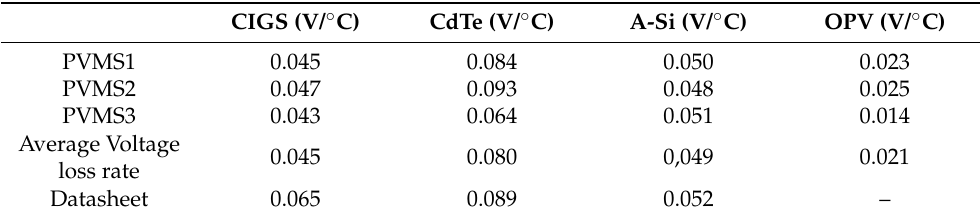
Table 4. Voltage loss rate due to temperature in the different monitoring stations.